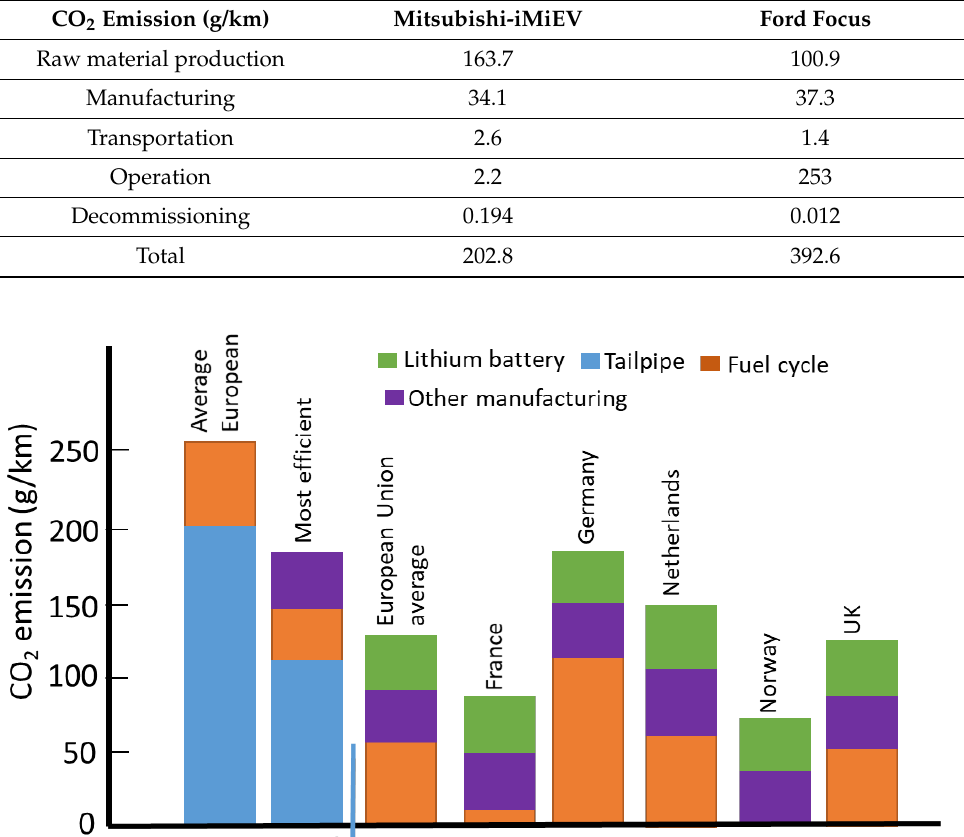
Figure 3. Life cycle analysis of medium-size gasoline internal combustion engine vehicle (ICEV) versus battery-powered engine vehicle (BEV) [redrawn from Ref. [80], open access]. 6. Technical Challenges and Social Aspects 6.1. Recycling of Spent LiBs A representative car battery in Nissan Leaf with 50 kWh (normal range: 40 – 60 kWh with 350 V lithium-ion) will lose about 20% of its original capacity after ten years of service [81]. Spent batteries are often reused for stationary energy storage or boats. For recycling, spent batteries are shredded into a powdered mixture, liquefied in a smelter (pyrometal- lurgy), or subject to acid (hydrometallurgy), followed by precipitation. Considerable ef- forts must be made for the economical recycling of spent batteries, e.g., the elimination of the shredding stage. Cathode materials can be separated using ultrasound sonication as cavitation at the electrode interface to break the adhesive bond rapidly to delaminate the electrode within seconds [82]. However, the transportation of heavy EV batteries and stor- age batteries to a recycling center is also costly. In Australia, only 2 – 3% of spent LiBs were collected and sent offshore for recycling in 2019, compared to <5% in the European Union